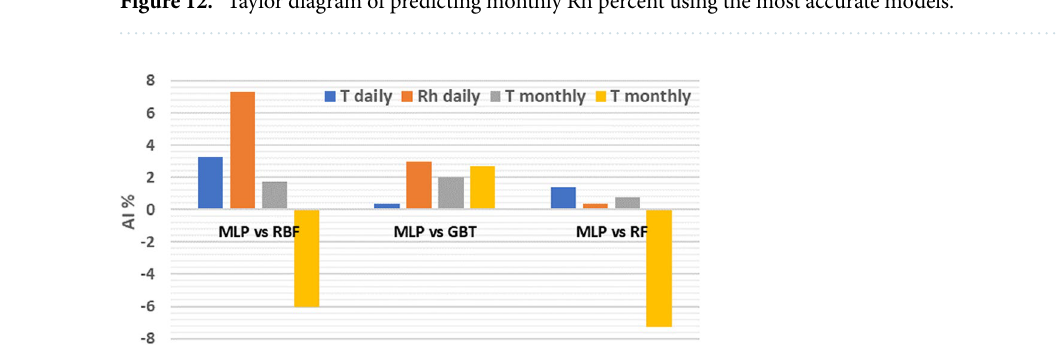
Figure 13. Summary of A.I. for MLP-NN over daily and monthly predict T and